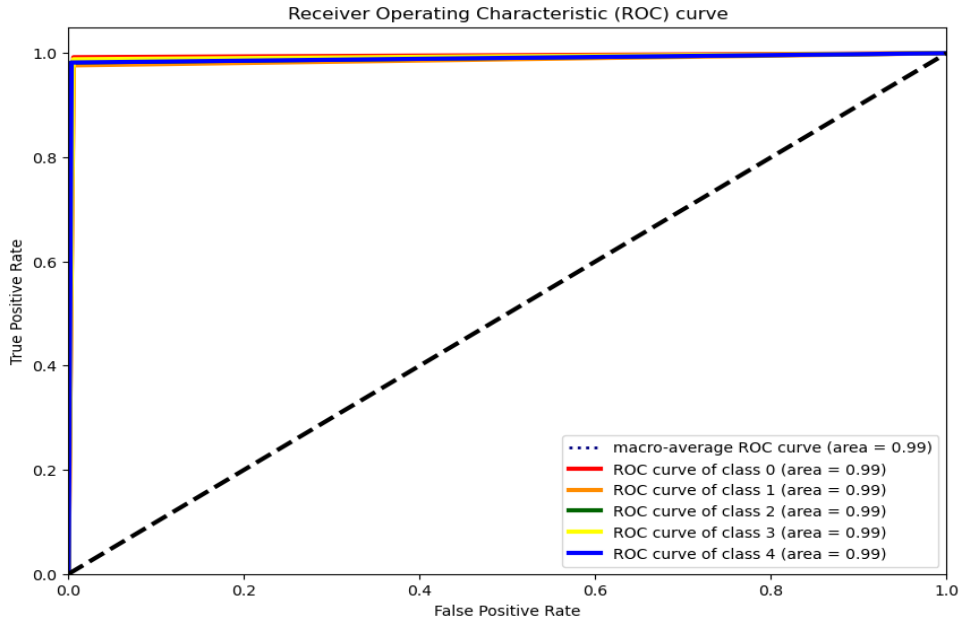
Figure 7. The ROC of the SVM model using traditional data split.